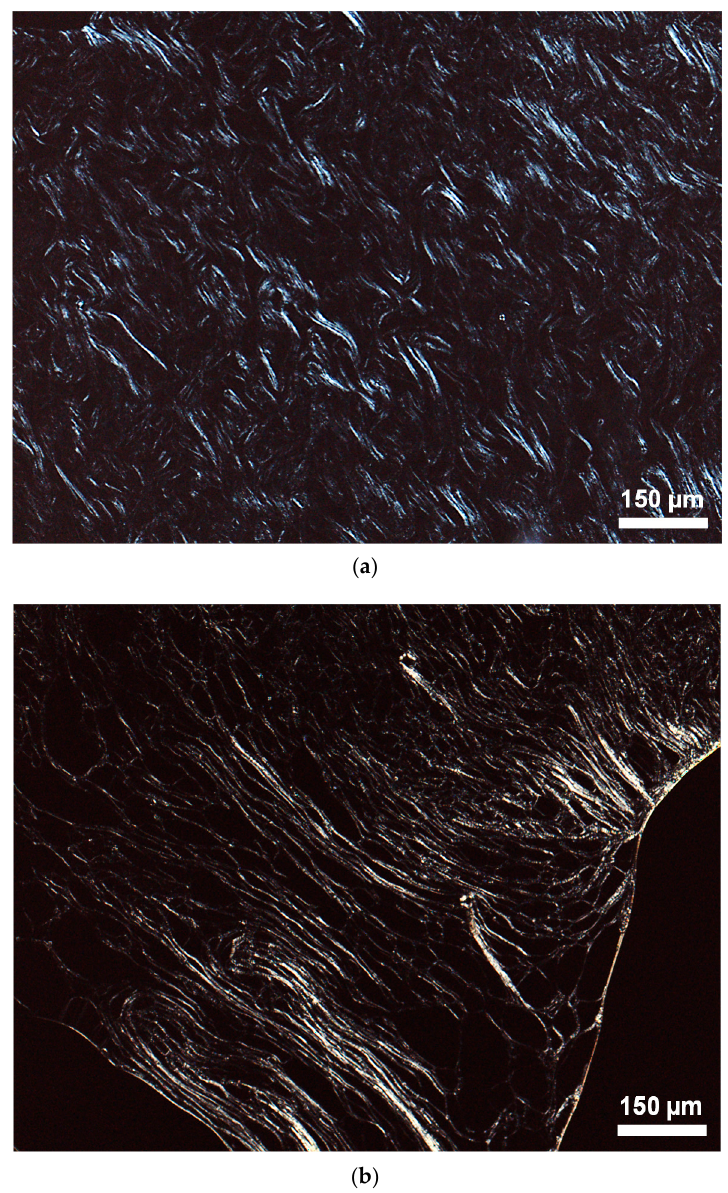
Figure 1. Polarized-light optical microscopy (POM) images of the SmA phases of ( a ) 1-11 at 24 °C (upon cooling from the isotropic liquid state and after applying pressure to the sample) and ( b ) 2 at 77 °C (during the first heating run of a pristine sample).